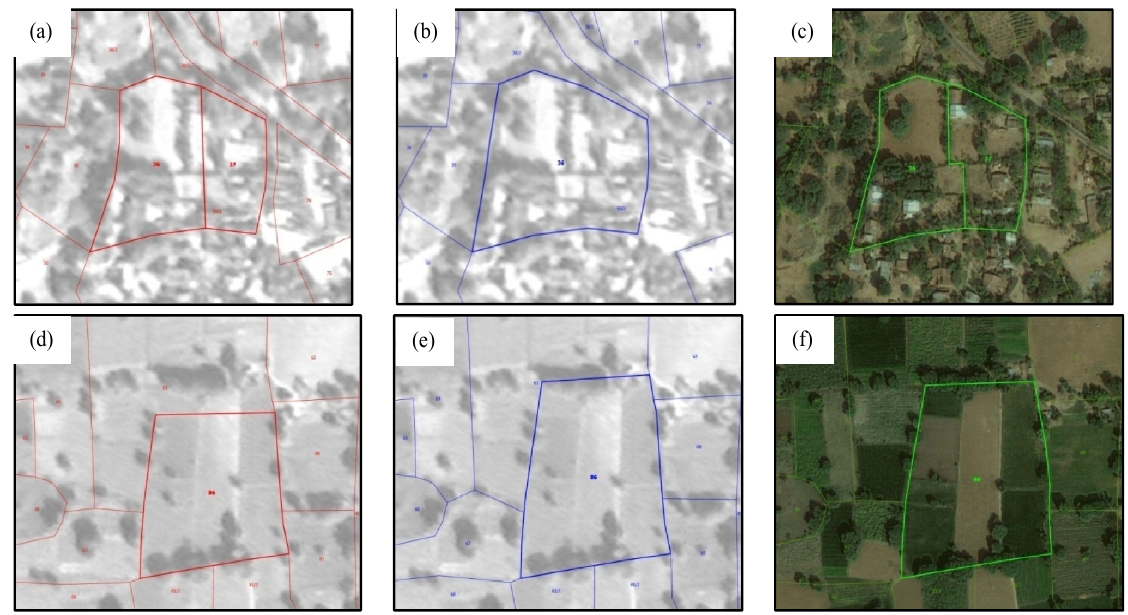
Figure 10. (a) Parcels 36 and 37 plotted in ETS-GPS Survey (b) Parcel 37 was not visible in CARTOSAT-2 hence two parcels were plotted as one and assigned number 36 (c) Parcels 36 and 37 plotted based on GEO-EYE imagery (d) Parcel 86 plotted in ETS-GPS